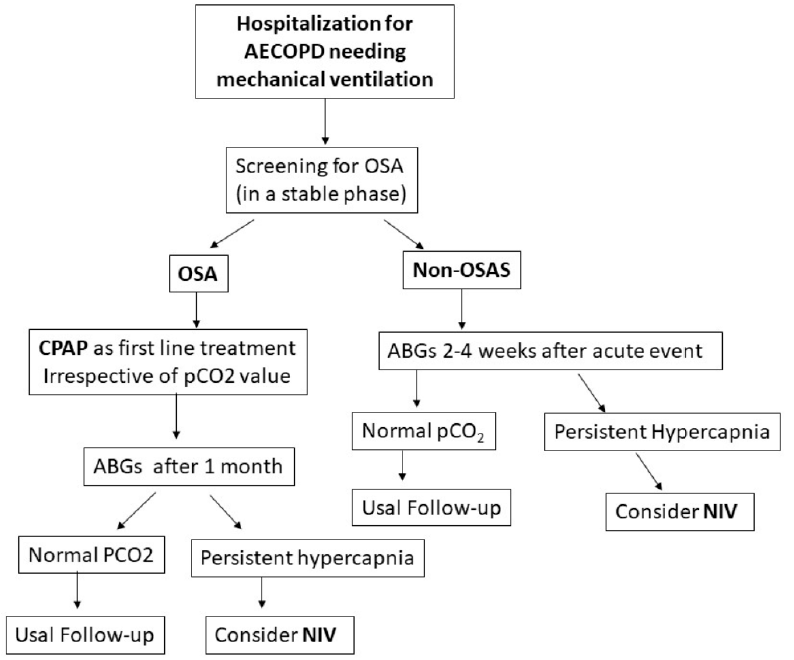
Figure 1. Shows a suggested algorithm for the management of patients after acute exacerbation of chronic obstructive pulmonary disease (AECOPD). Once patients are clinically stable (improved symptoms, normal pH despite weaning from NIV, no more need for antibiotics or oral steroids, no signs of cardiovascular decompensation), they should be screened for obstructive sleep apnea (OSA). Those diagnosed with OSA should start with continuous positive airway pressure (CPAP) therapy. Then, be followed up with as per the algorithm. Non-OSA patients should have arterial blood gases (ABG(cid:31)s) one month post-exacerbation and be managed as per the fl ow chart. NIV is non-invasive ventilation.